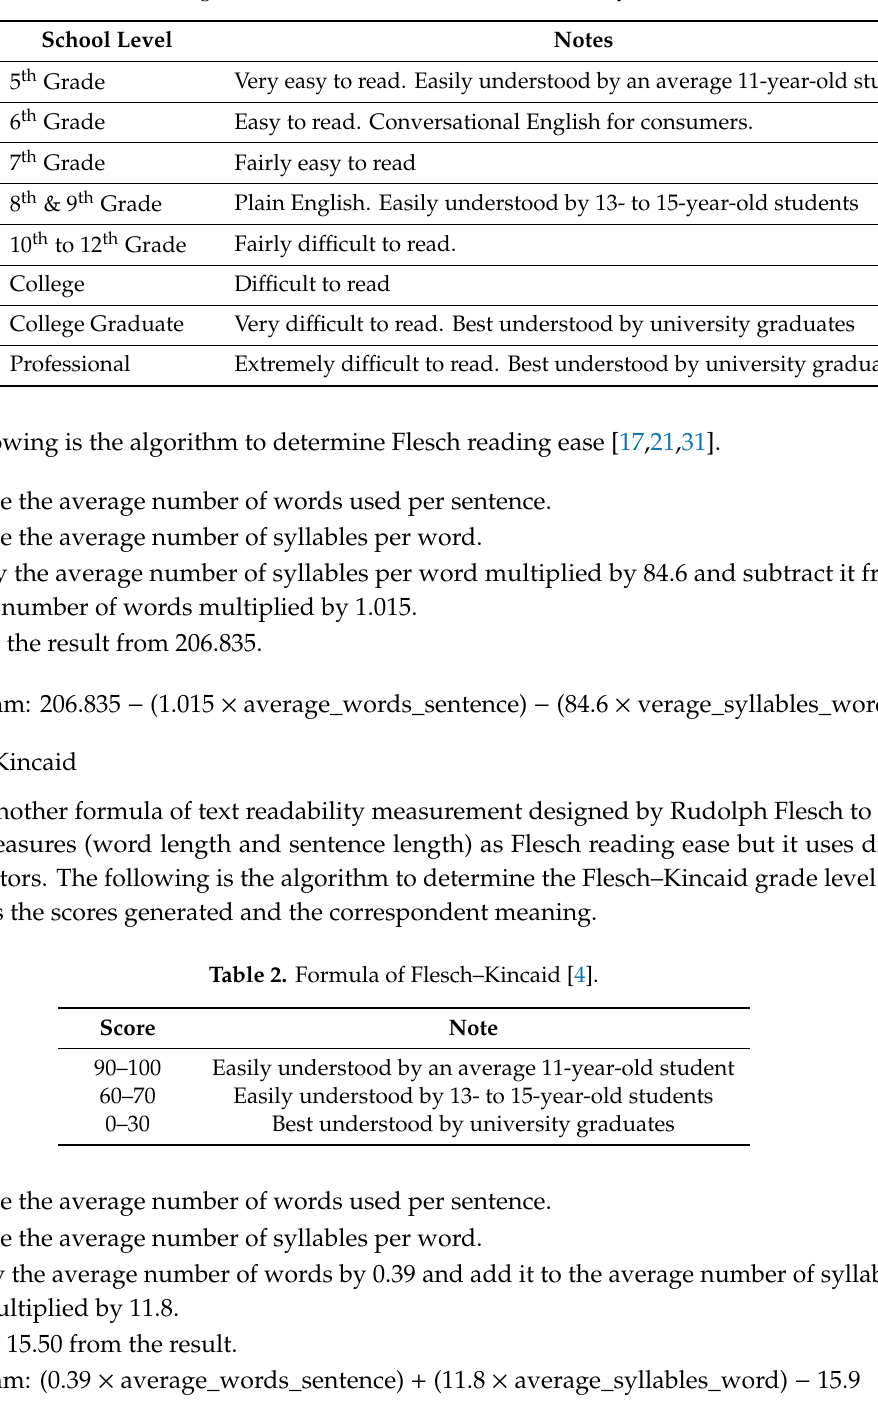
Table 1. Flesch reading ease score to assess the ease of readability in a document [31].